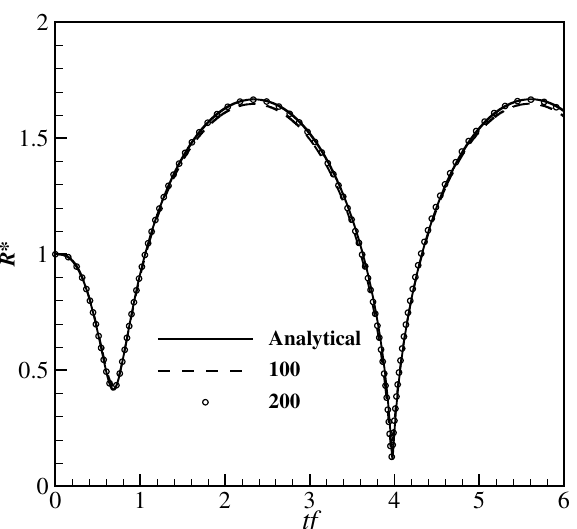
Figure 2. Isolated bubble: The time history of the bubble size R ∗ = R b / R b 0 in 1D simulation. Results of grid resolutions of 100 (d x = 4 R b 0 ) and 200 (d x = 2 R b 0 ) are compared with the analytical solution.